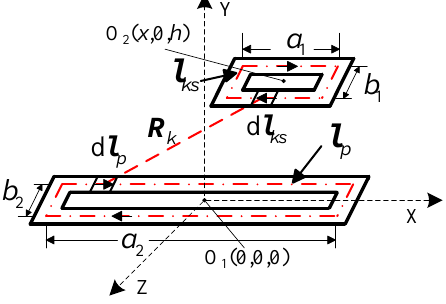
Figure 4. The diagram of mutual inductance calculation.